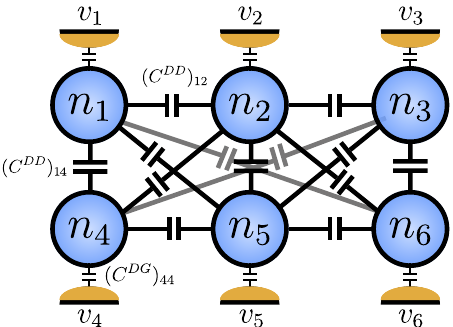
Figure 1: Schematic of a 2 × 3 array of capacitively coupled quantum dots, each occupied by n electrons, capacitively coupled to external gate voltages v i by a matrix C DG , and coupled to each other via capacitances C DD ij visualisation, the couplings C DG are only shown for i = j . In this device, the number ij of gate-voltages G equals the number of dots N =